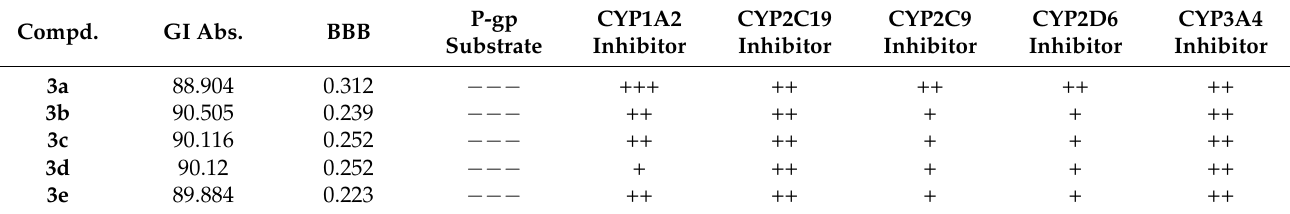
Table 7. ADME properties of compounds 3a–e .